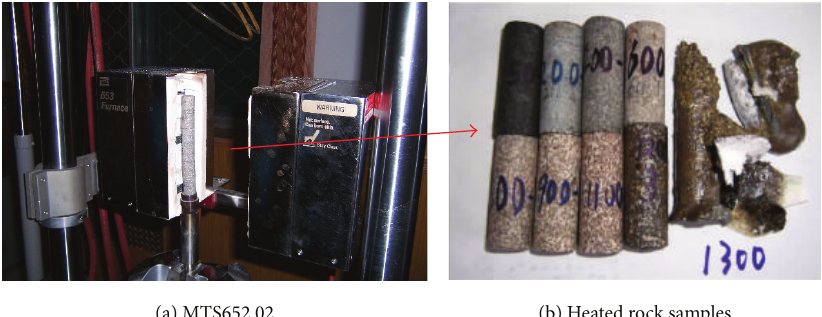
Figure 1: MTS652.02 and heated rock